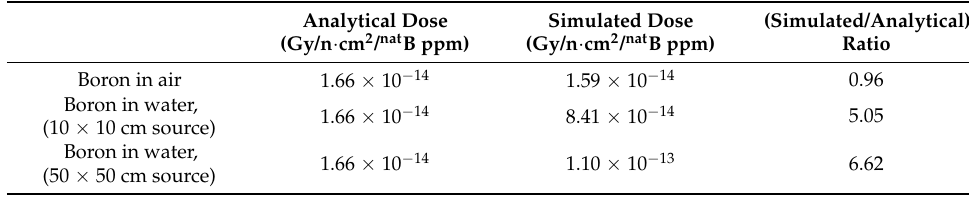
Table 5. Comparison of analytical and Monte Carlo dose in a boron volume.